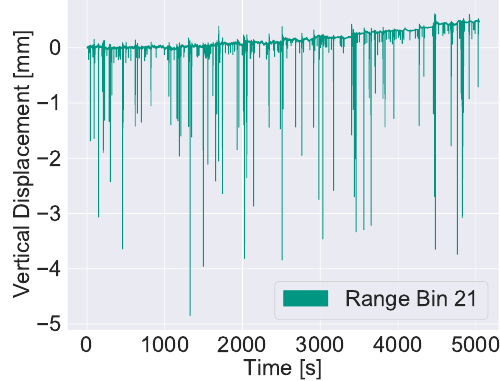
Figure 5. The vertical displacement of the selected range bin 12 as a time series over about 10 000s . The occurring peaks in the time series correspond to different events. The time-series data has been low-pass filtered (see Section